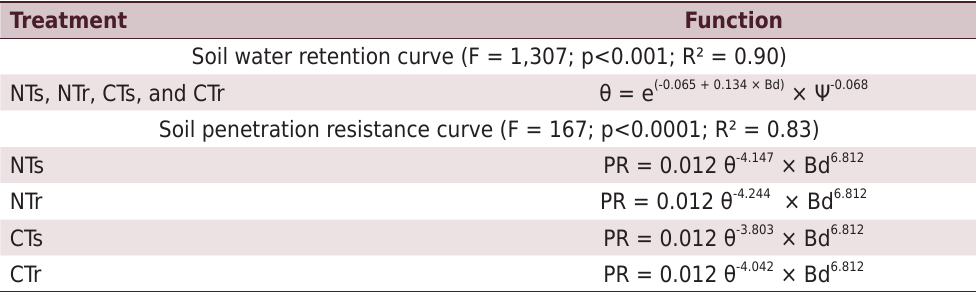
Table 4. Equations for soil water retention curve and penetration resistance curve of a Ferralsol under no-tillage (NT) and conventional tillage (CT) with crop rotation (r) and succession (s)